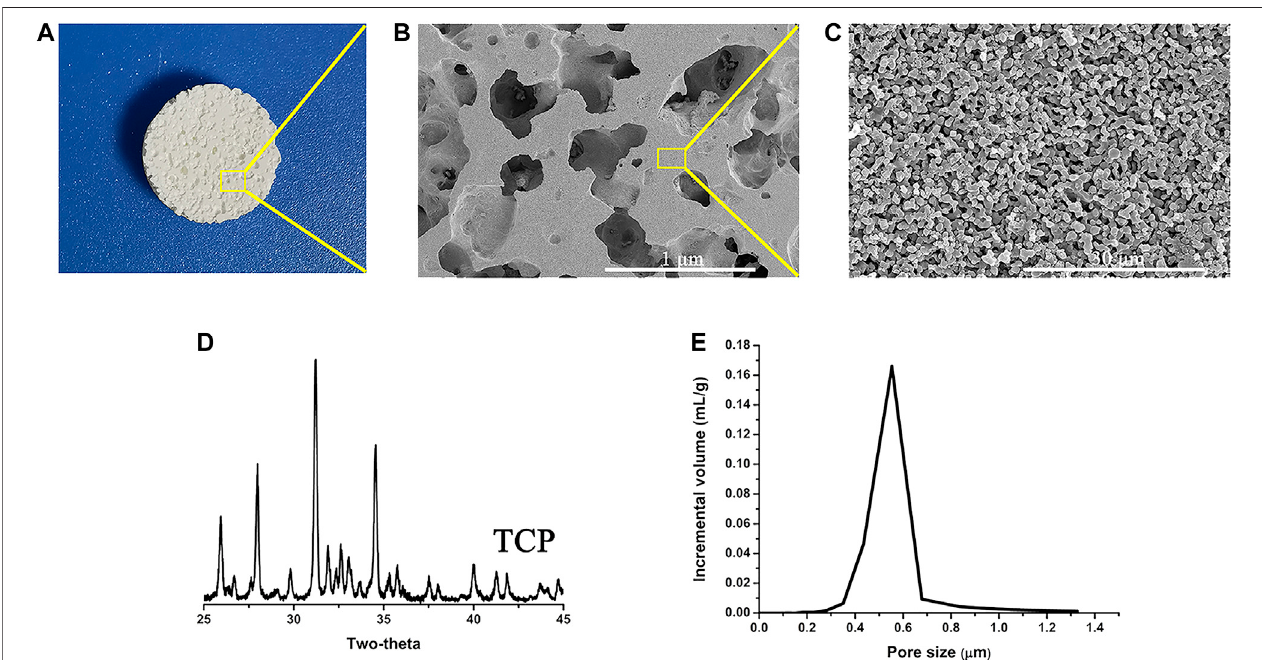
FIGURE 2 | Physical and chemical characteristics (A) CaP ceramic disc, (B) porous structure of CaP ceramic, (C) surface structure of CaP ceramic, (D) XRD pattern of the samples showing that the ceramic is ß -TCP, and (E) micropore size distribution con fi rmed by Mercury intrusion.